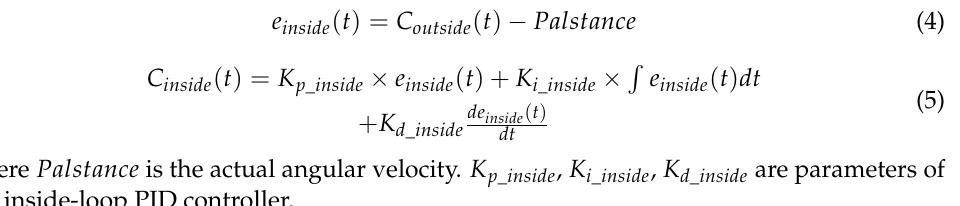
Figure 4. The cross-section of the balancing robot.